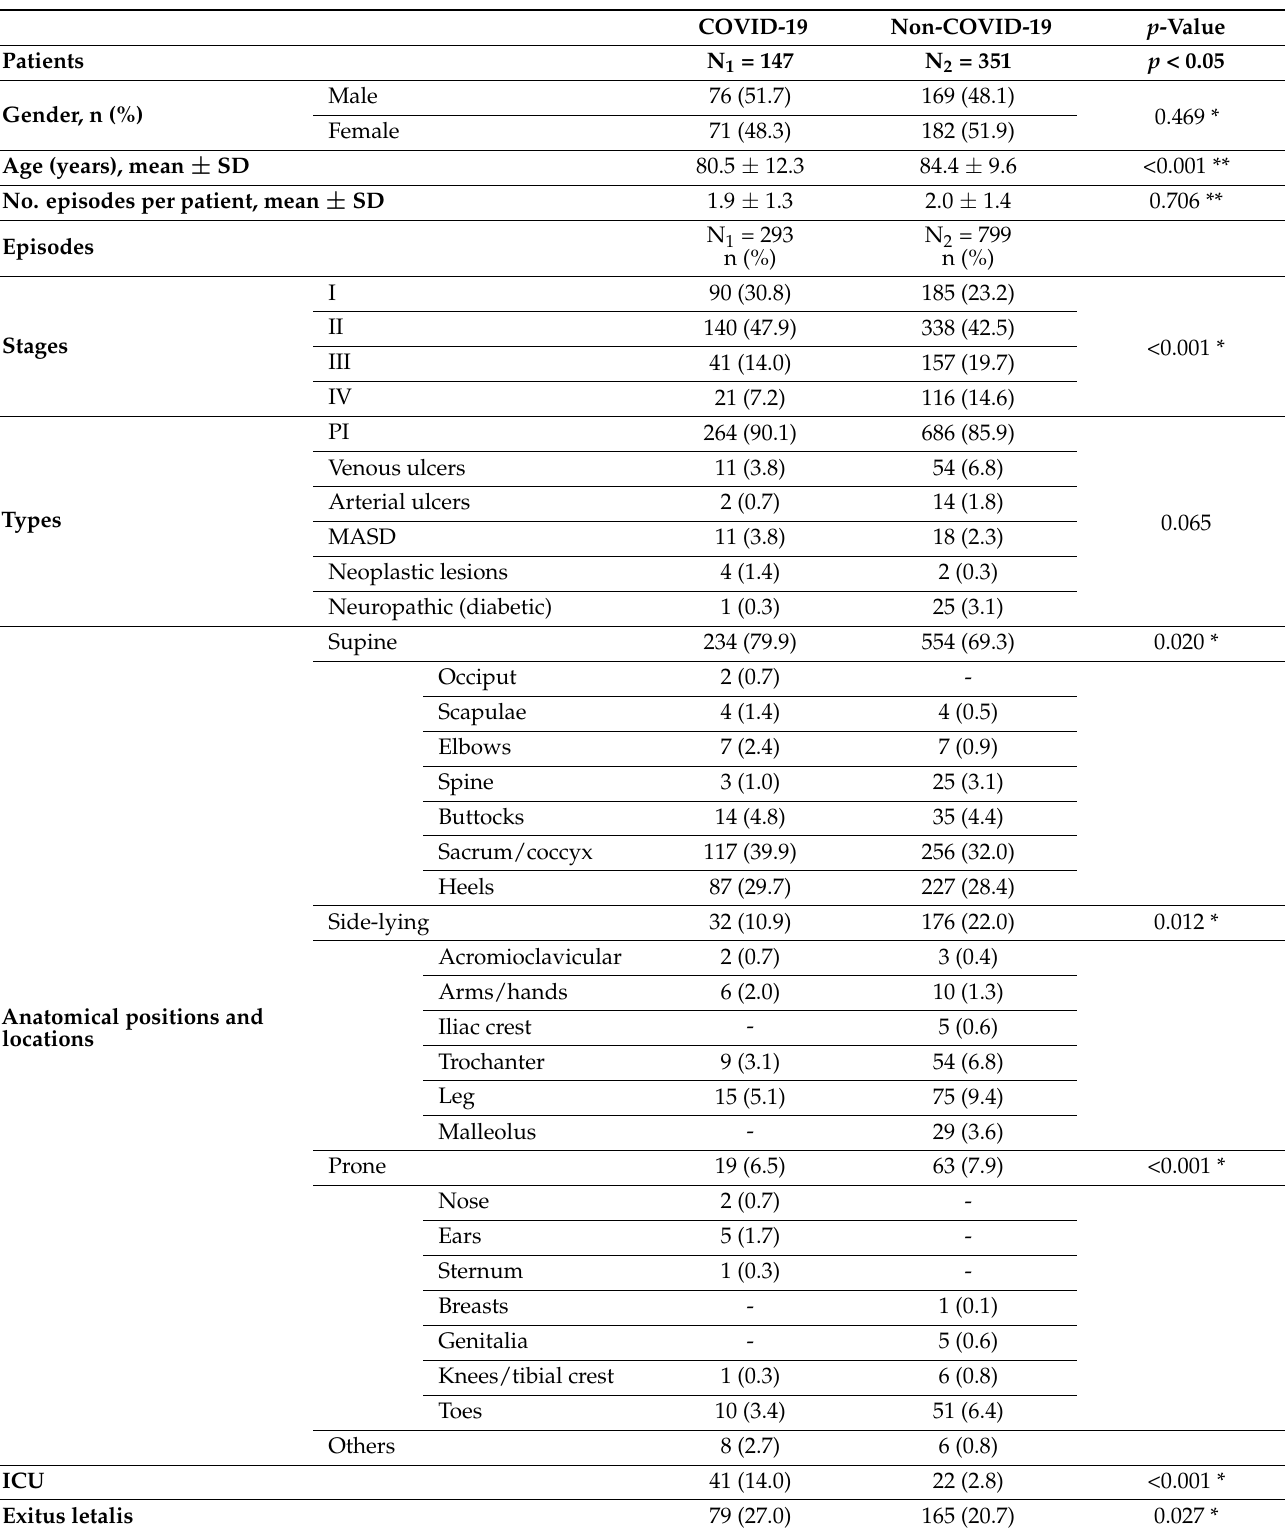
Table 3. Bivariate analysis testing the main clinical and epidemiological characteristics of skin wounds during first year of the COVID-19 pandemic: COVID-19 versus